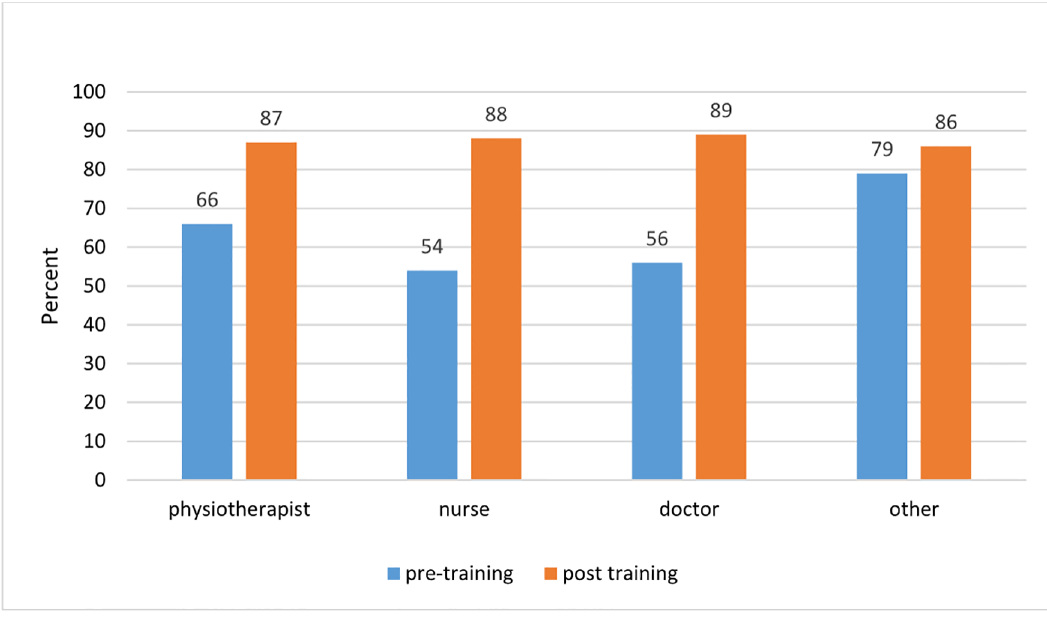
Fig 1. Pre- and post-course self-reported confidence as reported by cadre.